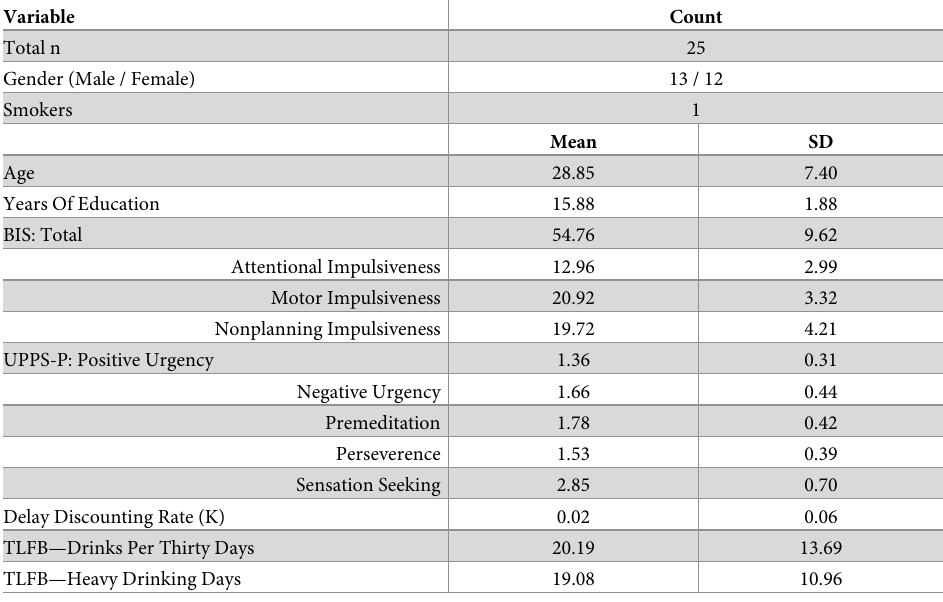
Table 1. Demographic, drinking, and impulsivity